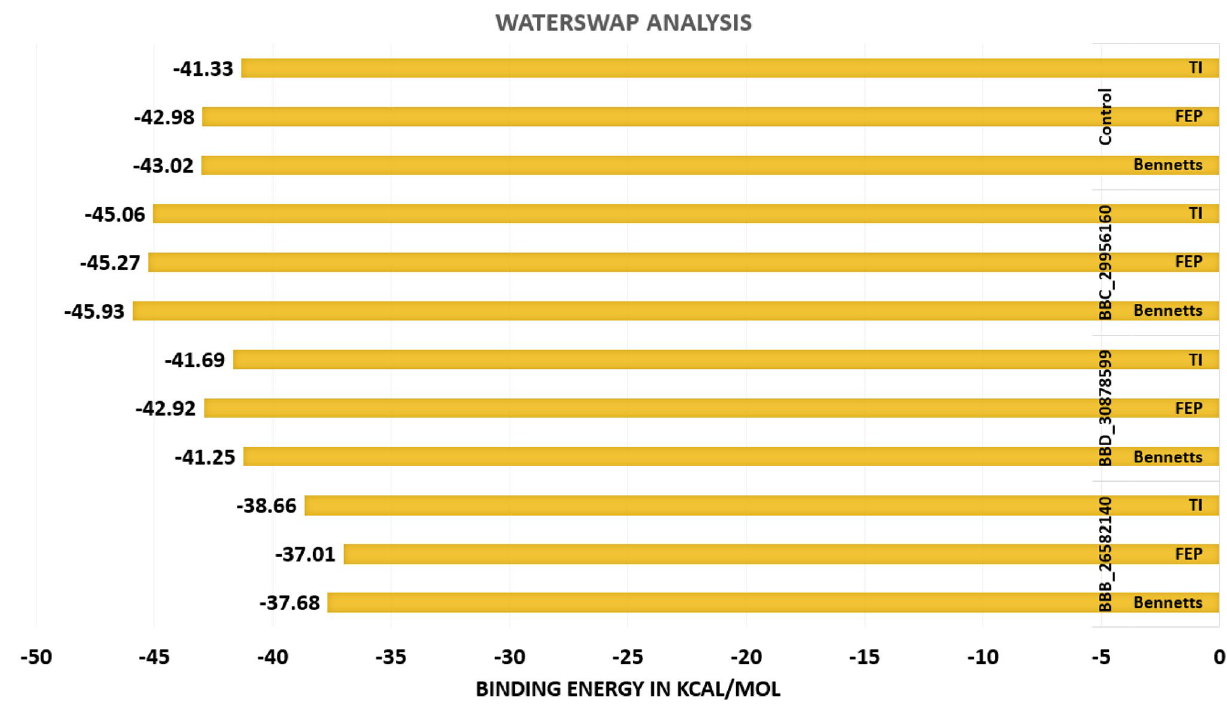
Figure 7. WaterSwap binding free energy in kcal/mol. The energy values are the outcome of three